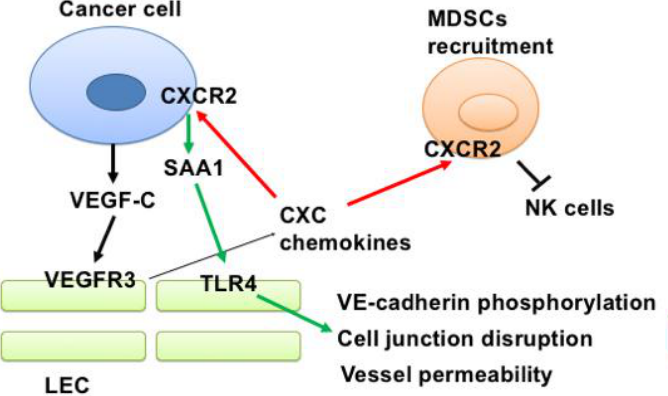
Figure 7. A scheme summarizes the findings of this study.